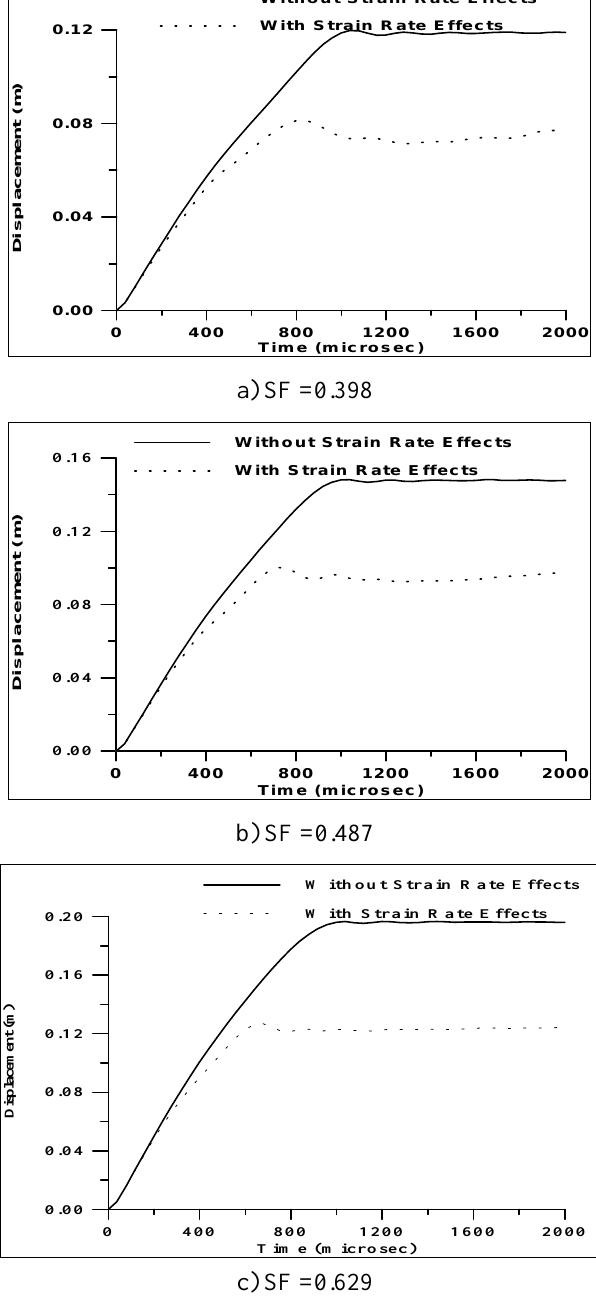
Fig. 11. Displacement time history for h/l = 0 . 1